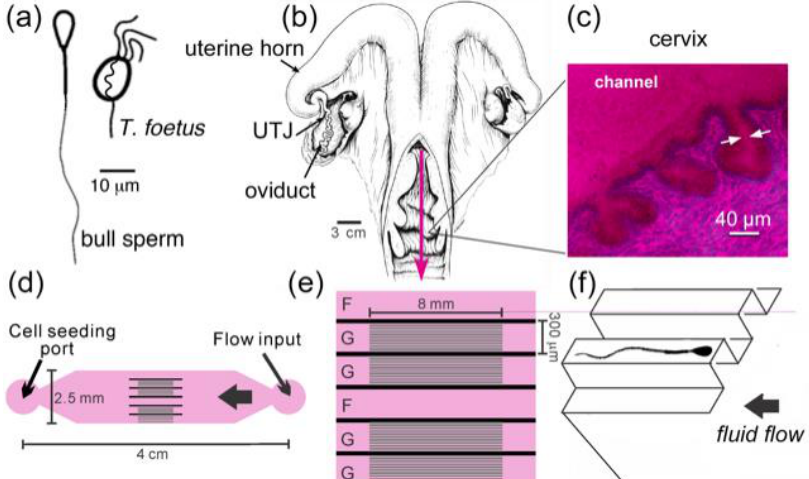
Figure 8. A microfluidic device designed to model fluid flows and microgrooves within the cervix. ( a ) Diagrams of bull sperm and T. foetus . ( b ) Illustration of a bovine female reproductive tract (from Ref. [108]). UTJ (uterotubal junction). The pink arrow points in the direction of fluid flow through the cervix. ( c ) Microgrooves are seen in PAS/hematoxylin-stained frozen sections of bovine cervix. ( d ) Diagram of microfluidic device that recreates the microgrooves and fluid flows of the bovine cervix. The sperm seeding port is on the left side and the flow inlet on the right; they are connected by channels with and without microgrooves. Detail of the channel design in the middle of the device: ( e ) G denotes channels with microgrooves in the upper surface and F denotes a control channel without grooves. ( f ) A 3D drawing illustrates the details of grooved channels. The cross-sectional dimensions of the microgrooves are 20 μm × 20 μm (drawing not to scale). Adapted with permission from Refs. [36]. Copyright 2015 Springer Nature.